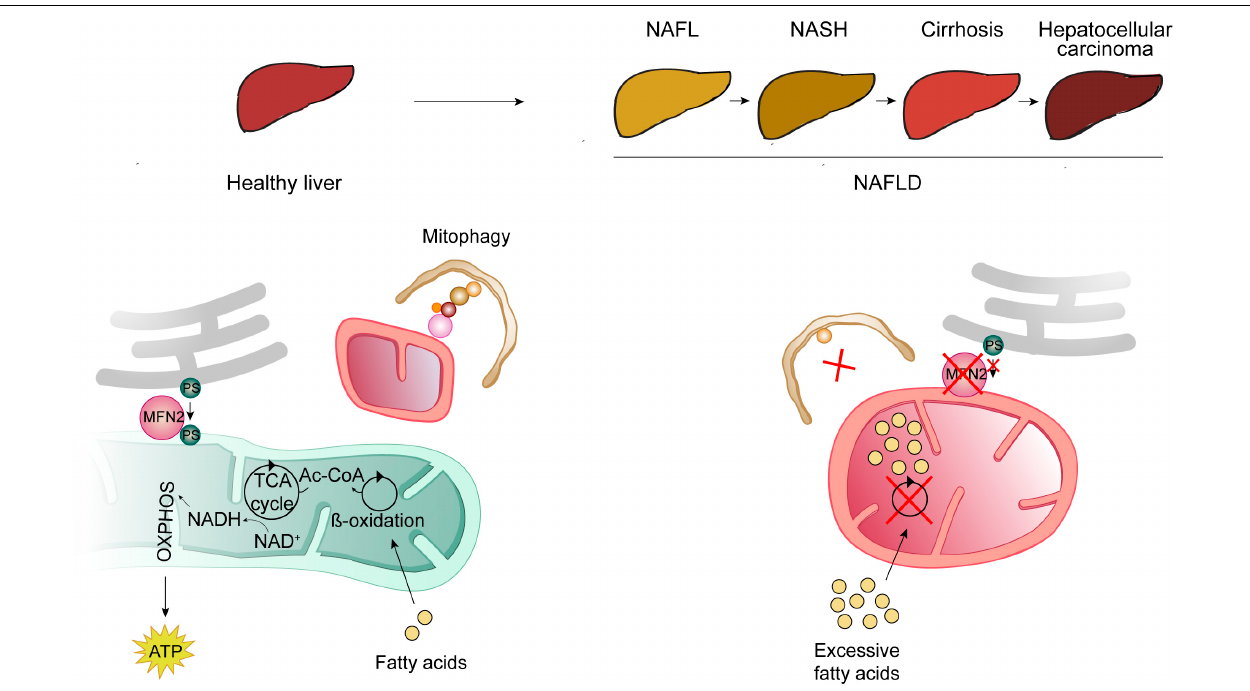
FIGURE 4 | Mitochondrial contribution for the development of non-alcoholic fatty liver disease (NAFLD). NAFLD consists of several heterogeneous clinical manifestations, usually organized in a development-stepwise-spectrum. The first step (NAFL) consists of the pathological accumulation of fat in the hepatocytes, due to excessive lipid intake and insufficient adipose storage. NAFL can evolve to further steatosis, accompanied by inflammation and scarring [(non-alcoholic steatohepatitis (NASH)], followed by cirrhosis and, ultimately, hepatocellular carcinoma. Mitochondrial dysfunction, also caused by low levels of MFN2, contributes to the development of NAFLD. In a healthy liver (left panel), free fatty acids are metabolized by β -oxidation into Acetyl-CoA (Ac-CoA), which can then enter the citric acid (TCA) cycle, from which NADH is produced and further used by the oxidative phosphorylation chain (OXPHOS) to produce energy in the form of ATP. These healthy mitochondria are kept in check by mitophagy (for details see Figure 1 ). Also in a healthy situation (left panel), MFN2 was proposed to serve as a tether between mitochondria and ER and thereby to also bind to and promote the transfer of phosphatidylserine (PS) from the ER to mitochondria. In a situation of excessive lipid intake and NAFLD development (right panel), mitophagy is impaired, leading to the accumulation of dysfunctional mitochondria, unable to metabolize fatty acids, which accumulate in hepatic mitochondria and lead to steatosis. Furthermore, the absence of MFN2 impairs PS transfer to mitochondria, affecting further lipid biosynthesis, consequently leading to ER stress in